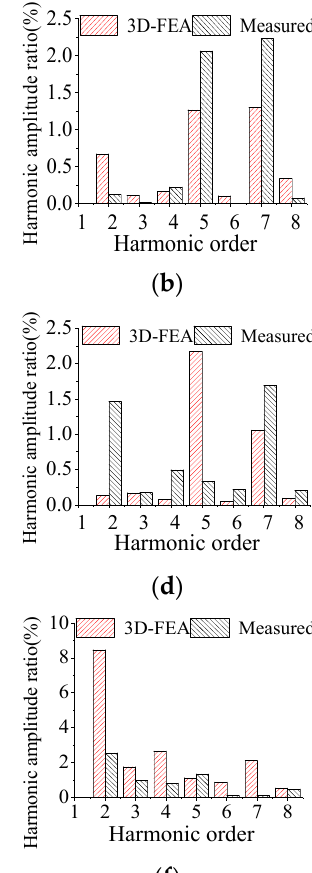
Figure 23. Output torque for two machines with different current densities. ( a ) AMC-FRPM. (b) FRPM.